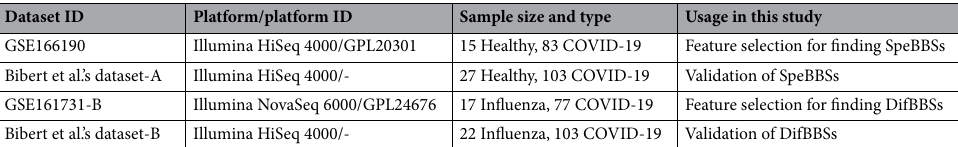
Table 2. Datasets used for feature selection and validation of blood biomarker signatures by machine learning